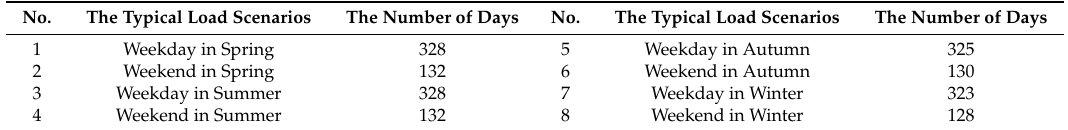
Table 3. The typical load scenarios information of the 173 nodes system.